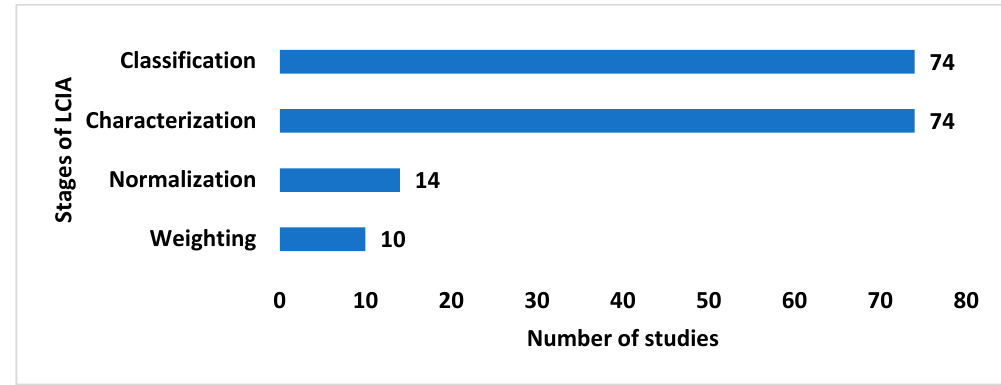
Figure 13. Phase 3 (impact assessment) of life cycle assessment (LCA).